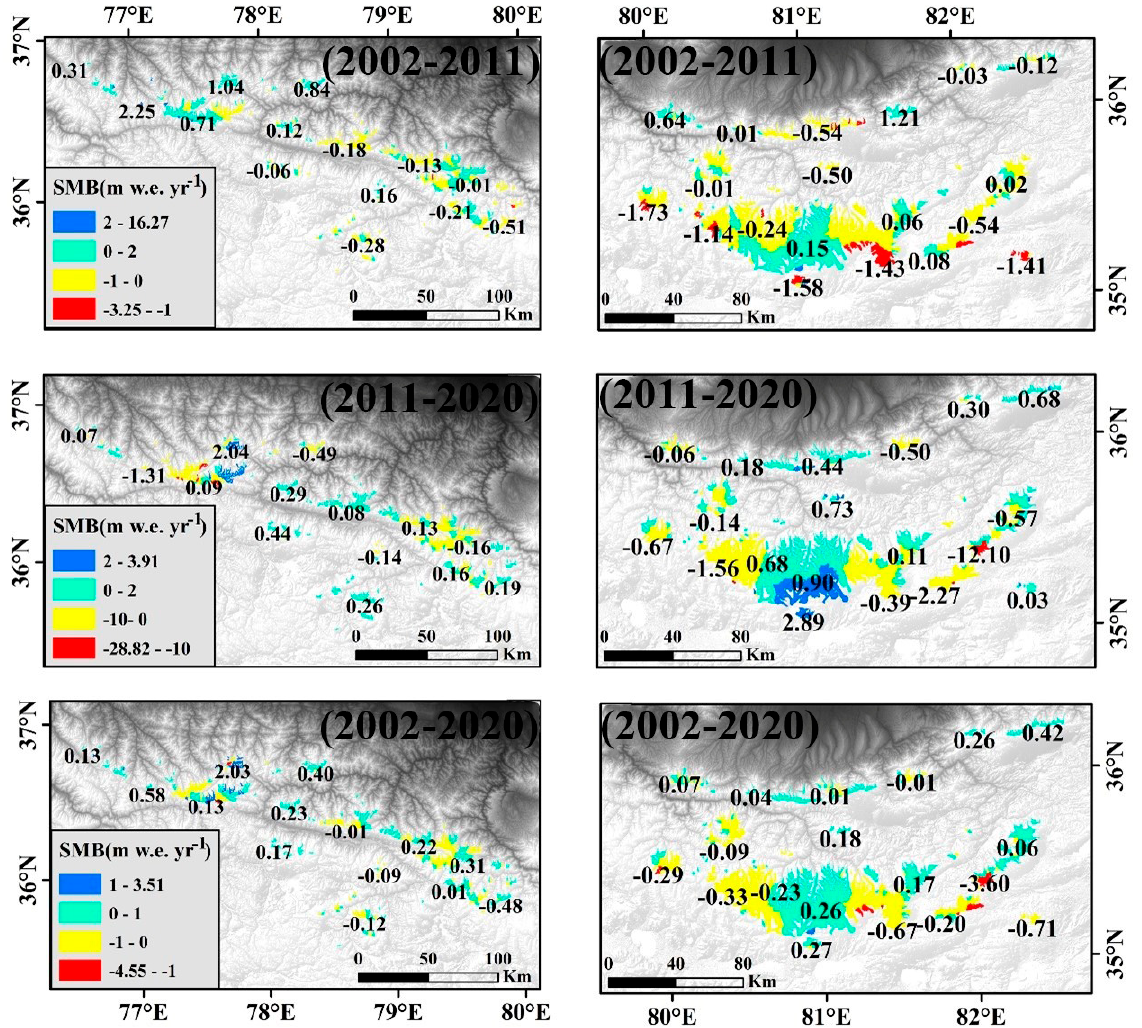
Figure 3. Glacier SMB spatial pattern differences in western WK (in the left three subplots) and eastern WK (in the right three subplots) in the past two decades.